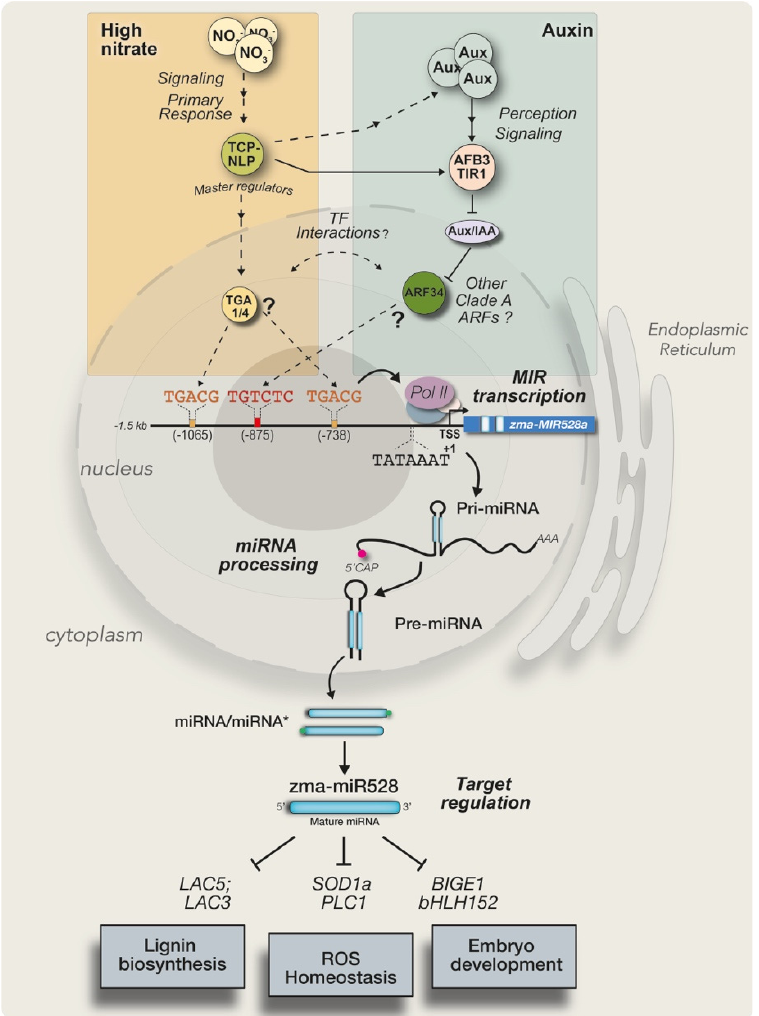
Figure 8. A proposed model for nitrate- and auxin-mediated transcriptional regulation over zma- MIR528a . Perception of high nitrate triggers primary signaling guided by master regulators to activate several TFs. TGA1, TGA4, and other TFs would recognize cis -regulatory elements in the promoter of zma- MIR528a to enhance its expression in response to the stimulus. Furthermore, elevated auxin concentration promotes the activation of AFB3 and TIR1 to polyubiquitinate the repressor Aux/IAA, setting free the clade A ARFs (transcriptional activators, such as ARF34) to interact with AuxRE at the promoter and stimulate transcription. Both pathways could overlap through TCP/NLP-mediated regulation of both auxin biosynthesis and response pathways. The nitrate signal induces auxin biosynthesis (dashed lines) as master regulators of this route promote the expression of genes involved in tryptophan metabolism to obtain IAA. These regulators and the nitrate-sensing machinery also control the nitrate–AFB3/TIR1 auxin perception to activate ARFs (solid line). Both stimuli activate MIR528a expression through TFs’ interaction with their binding sites. As a consequence of such coordinated regulation, miR528 level increases to down-regulate its mRNA targets.